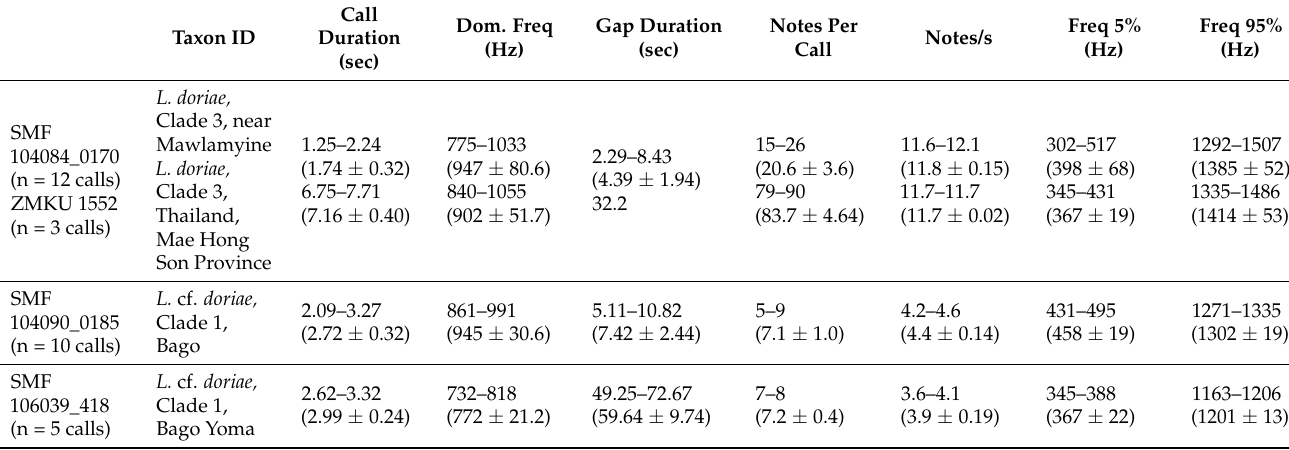
Table 2. Selected bioacoustic parameters of the species related to Limnonectes doriae. Range is followed by mean value and standard deviation in parentheses. Dom. Freq. = dominant frequency; Freg. =